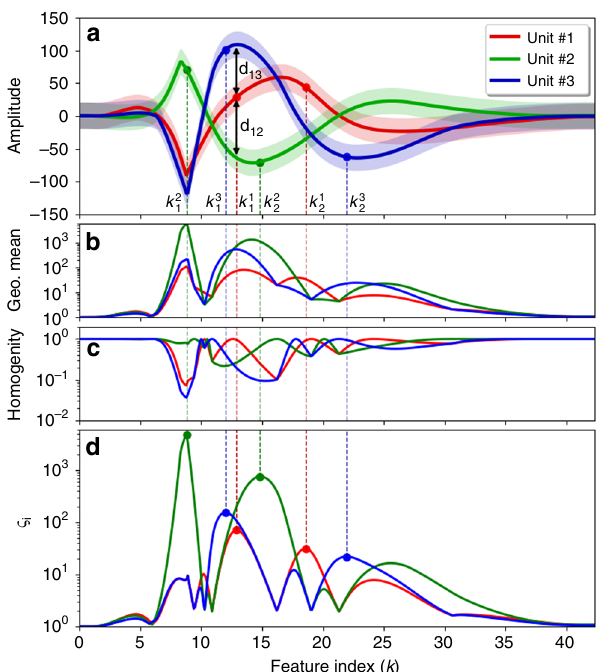
Fig. 3 Details of salient feature selection. a A typical spike sorting problem with three spike classes. b Geometric mean values for the exponential class discrimination indices d ij 's. c Homogenity of d ij 's. d Class saliency ( ς i ), which is indeed the product of geometric mean values of d ij 's and the associated homogenties. The criterion for identifying the feature that best distinguishes a given spike class from all other classes (the most salient feature) is where saliency of that class is maximized. The samples (features) shown by solid circles on each spike are the most salient features, using which that spike is distinguished from other spikes in the best way.